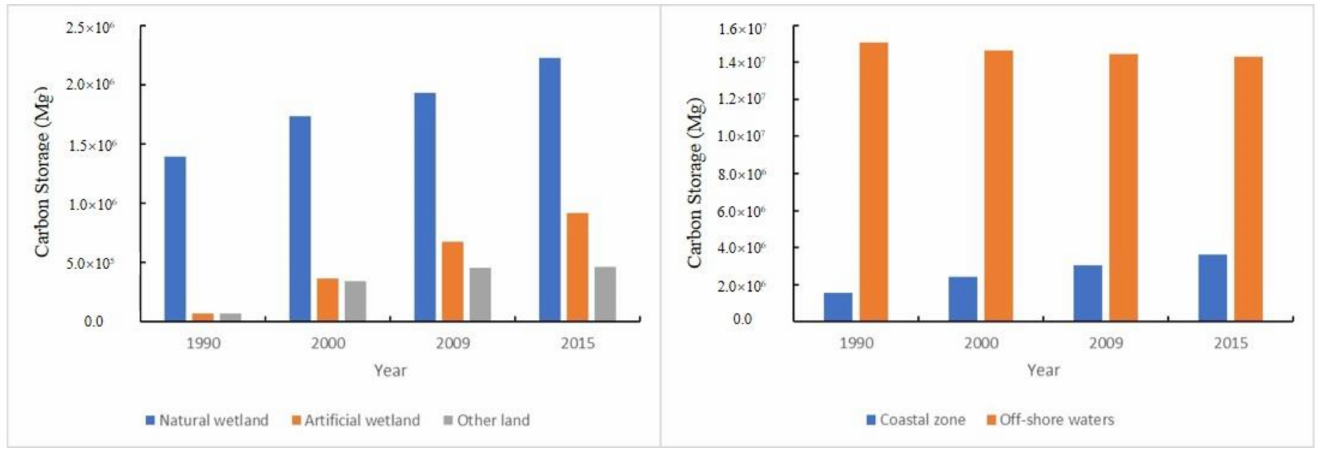
Figure 4. Comparison of the blue carbon storage of natual wetlands, artificial wetlands and other land types in the Shanghai coastal area during